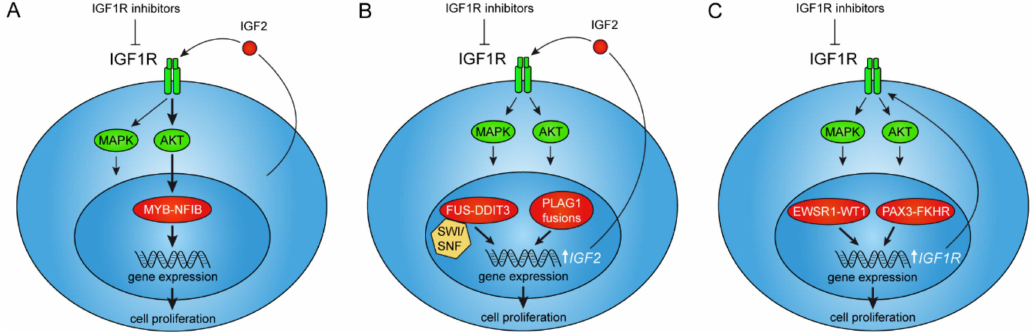
Figure 1. Interactions between oncogenic gene fusions and IGF2 / IGF1R signaling. ( A ) The MYB–NFIB fusion is positively regulated by AKT-dependent IGF1R signaling as a result of autocrine IGF2-stimulation in adenoid cystic carcinoma. ( B ) PLAG1 and FUS–DDIT3 fusions directly regulate expression of the IGF2 -gene leading to autocrine stimulation of IGF1R signaling in pleomorphic adenoma, hepatoblastoma, and myxoid liposarcoma. ( C ) The EWSR1–WT1 and PAX3–FKHR fusions regulate transcription of the IGF1R gene leading to overexpression of its encoded tyrosine kinase receptor in desmoplastic small round cell tumor and alveolar rhadomyosarcoma, respectively. 3. IGF Signaling as a Therapeutic Target in Tumors with Activation of the PLAG1